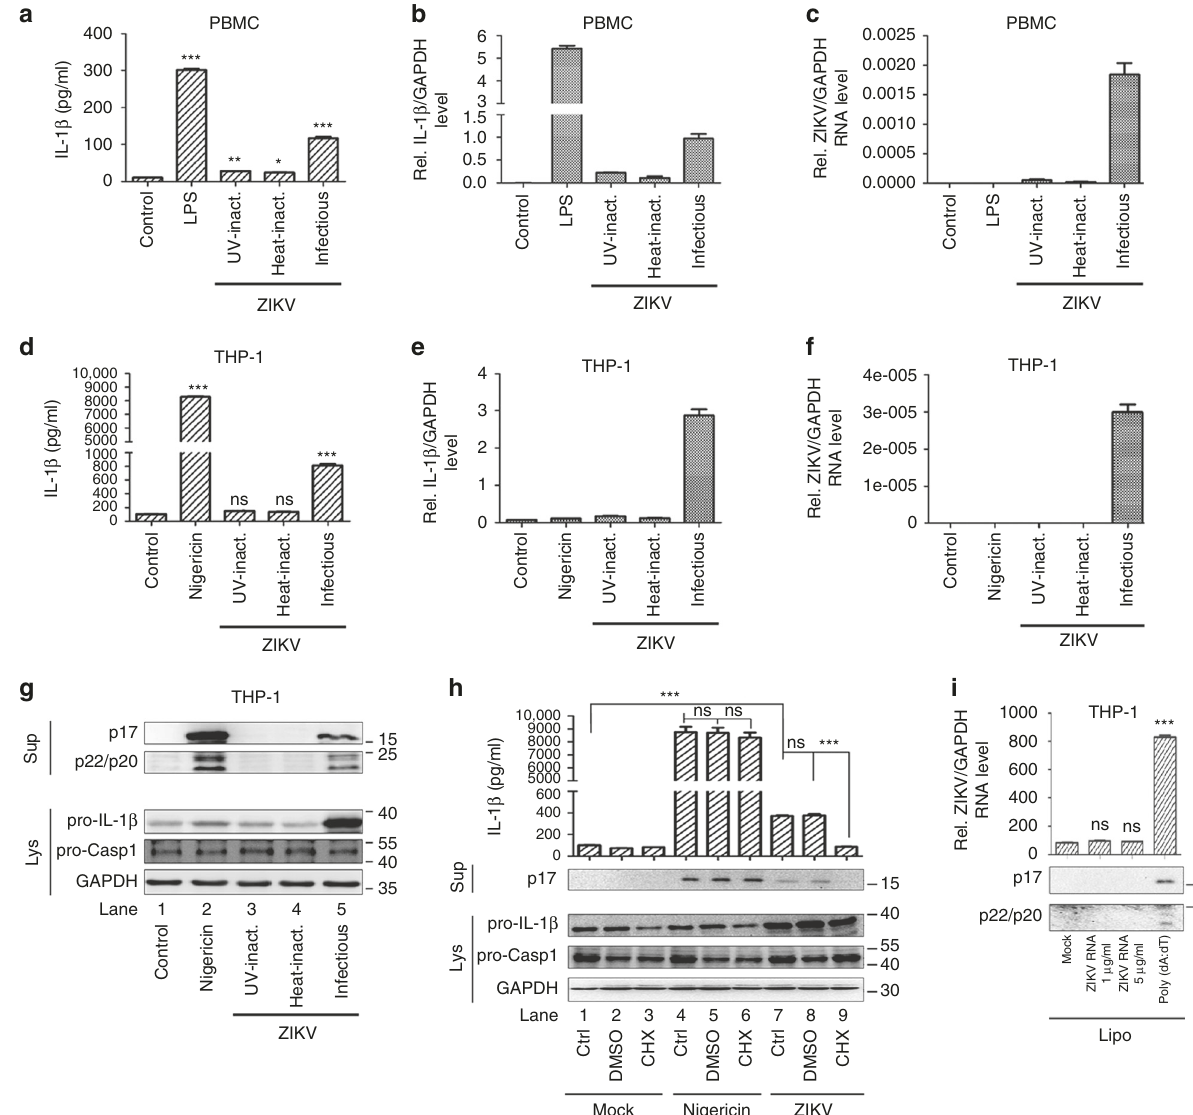
Fig. 3 The requirements of ZIKV replication and protein production for the activation of the NLRP3 in fl ammasome. a – g Human PBMCs were treated with LPS (1 μ g/ml) for 6 h ( a – c ) or THP-1-differentiated macrophages were treated with 2 μ M Nigericin for 2 h ( d – g ) and then infected with ZIKV at an MOI = 1 for 48 h or inoculated with heat-inactivated or UV-inactivated ZIKV for 48 h. IL-1 β levels in the supernatants were determined by ELISA ( a , d ). Pro-IL-1 β and GAPDH mRNA ( b , e ) or ZIKV and GAPDH mRNA ( c , f ) levels were quanti fi ed by RT-PCR. Mature IL-1 β (p17) and cleaved Casp-1 (p22/p20) levels in the supernatants (top) and pro-IL-1 β , pro-Casp-1, and GAPDH levels in cell lysates (Lys) (bottom) were determined by western blot ( g ). h THP-1-differentiated macrophages were treated with 100 μ M CHX for 1 h, treated with 2 μ M Nigericin for 2 h or infected with ZIKV at an MOI = 1 for 24h. IL-1 β levels in the supernatants were determined by ELISA (top). Mature IL-1 β (p17) levels in the supernatants and pro-IL-1 β , pro-Casp-1, and GAPDH levels in cell lysates (Lys) were determined by western blot (bottom). i THP-1-differentiated macrophages were treated with Lipo, stimulated with Lipo plus poly(dA:dT), or treated with Lipo and transfected with 1 or 5 μ g/ml genomic RNA of ZIKV for 6 h. IL-1 β levels in the supernatants were determined by ELISA (top), and mature IL-1 β and cleaved pro-Casp-1 protein levels in supernatants were determined by western blot (bottom). The number of replicates is two ( a , d , h , i ). The number of replicates is three ( b , c , e , f ). Data shown are means ± s.e.m; * P < 0.05, ** P < 0.01, *** P < 0.0001; ns, no signi fi cance (one-way ANOVA with Tukey ’ s post-hoc